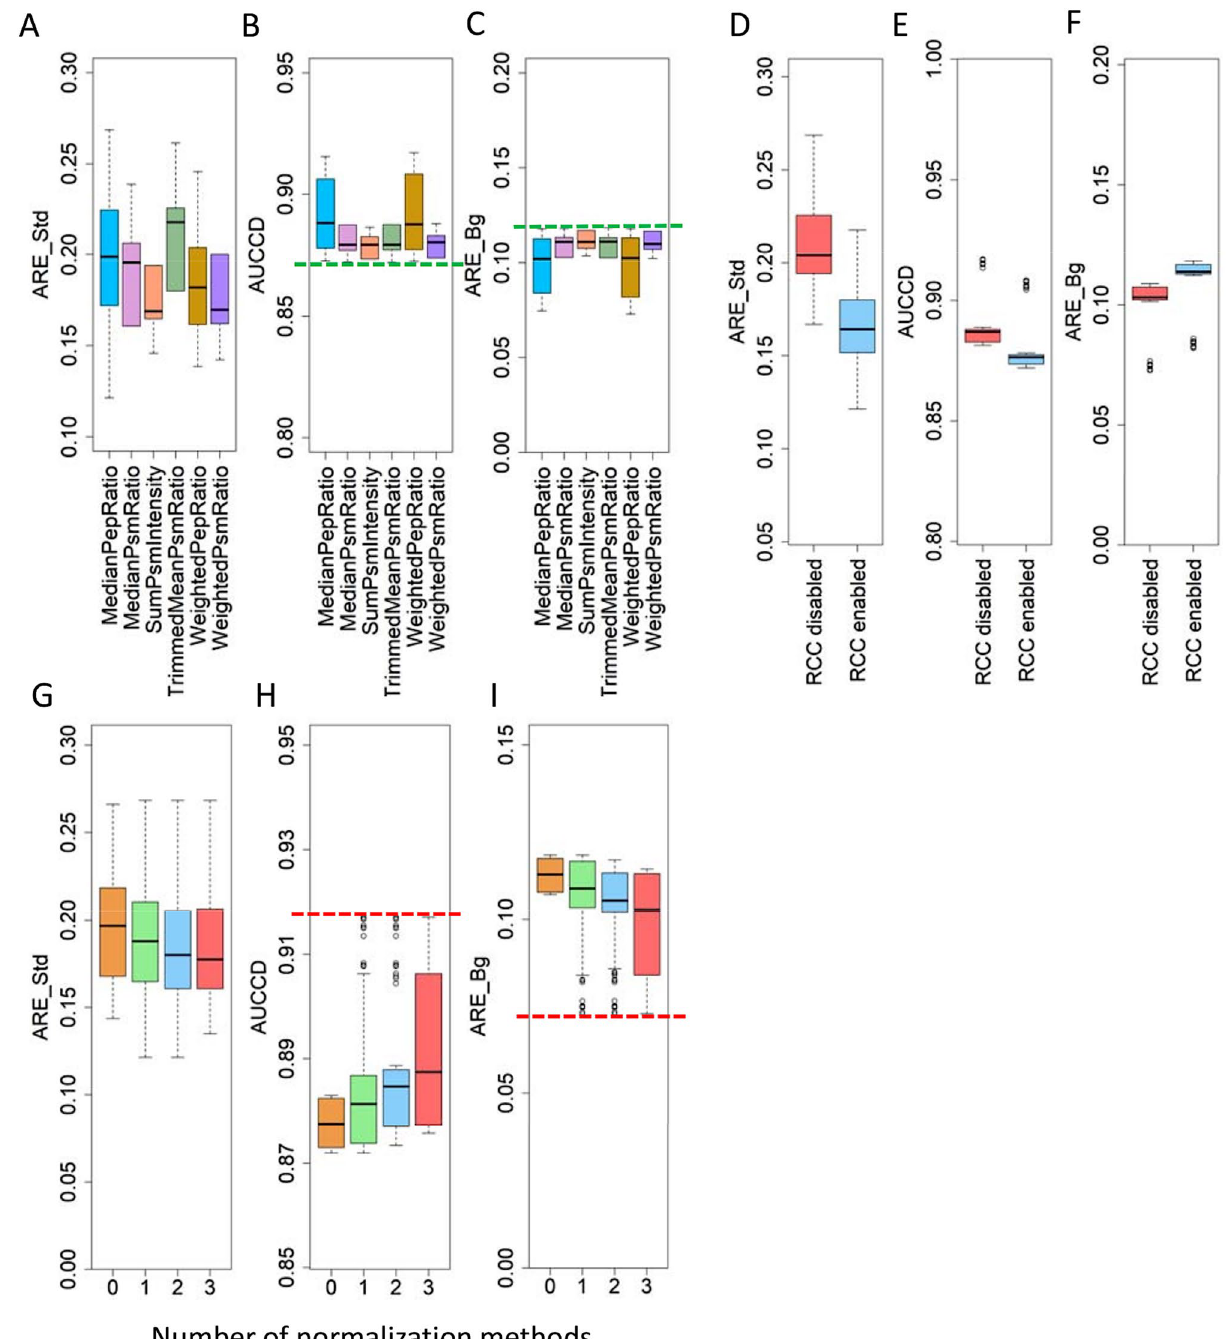
Figure 2. Summarizations of evaluation on algorithmic combinations for ( A – C ) different protein ratio calculation algorithms, ( D – F ) RCC enabled and disabled, and ( G – I ) the number of normalization methods based on Gatto-TMT6. Evaluation measures include average relative error of standard proteins (ARE_Std), area under the curve of coverage vs. deviation (AUCCD), and average relative error of background proteins (ARE_ Bg). Each boxplot in panels A–C and D–F represents a summarization of 56 and 168 algorithmic combinations, respectively. Boxplots of 0, 1, 2, and 3 normalization methods in panels G-I correspond to summarizations of 48, 144, 96, and 48 algorithmic combinations,